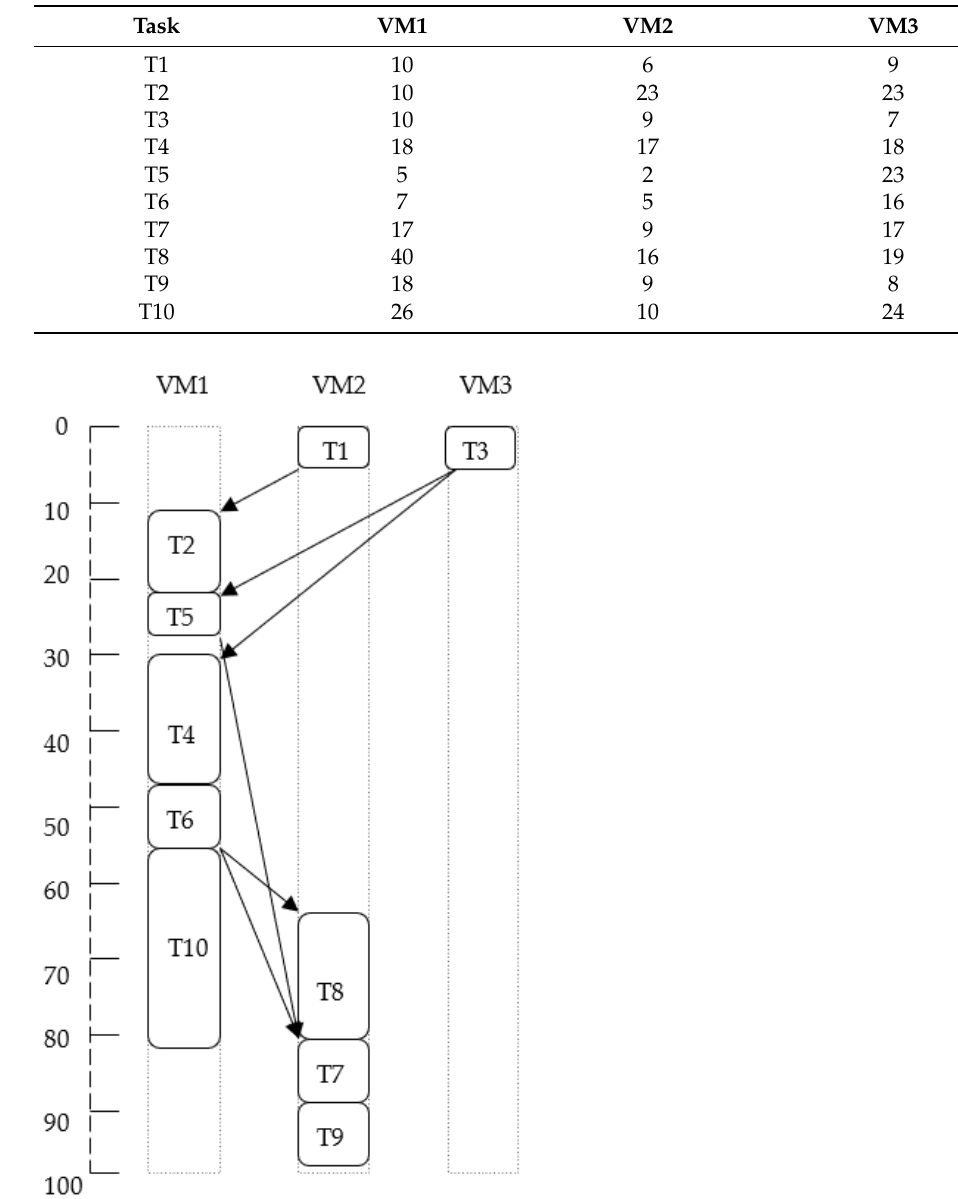
Table 2. Probable execution cost (PEC) matrix.